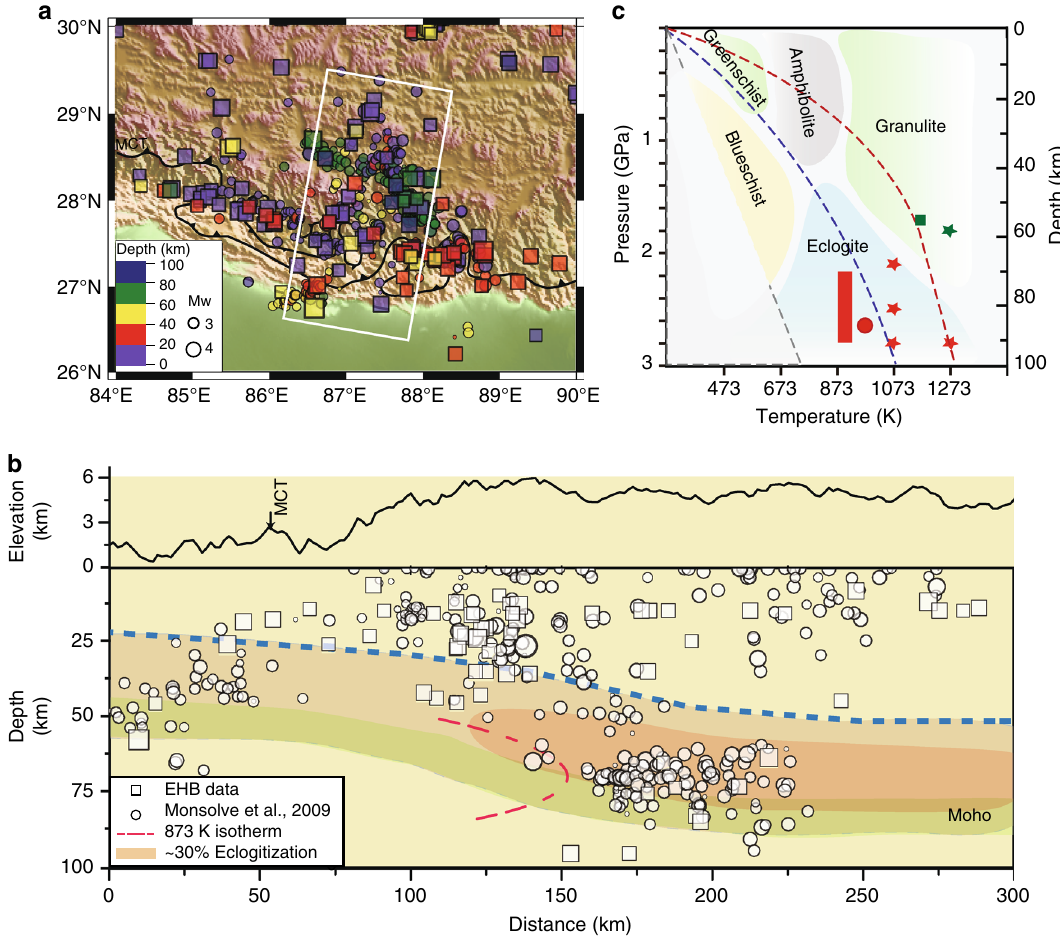
Fig. 1 Seismicity in southern Tibet and the relation to granulite-eclogite metamorphic reaction. a A map view of the area of interest with earthquake locations from the EHB Bulletin (http://www.isc.ac.uk/ehbbulletin/) (relocated using teleseismic data) and from relocation 14 using the Himalaya Napel Tibet Seismic Experiment 18 data. b A schematic cross-section view normal to the arc of the Main Central Thrust with earthquake hypocenters shown in a . The blue dashed line marks the approximate boundary between the Tibetan crust (above) and the subducted Indian crust (below). The range of the Moho depths is indicated by the greenish band, whose upper, and lower bounds are from 14 and 57 , respectively. “ 873 K isotherm ” from thermokinematic modeling 57 and the “ 30% eclogitization ” region based on received function models 32 are indicated. c A schematic phase diagram of granulite-facies rocks in relation with other facies (modi fi ed from 70 ). Estimated P-T conditions of xenolith samples are given as the following: eclogite — red rectangle 36 and red circle 37 ; granulite — green squares 31 . Experimental conditions are given as color-coded stars. Red symbols are in eclogite fi eld and green in granulite fi